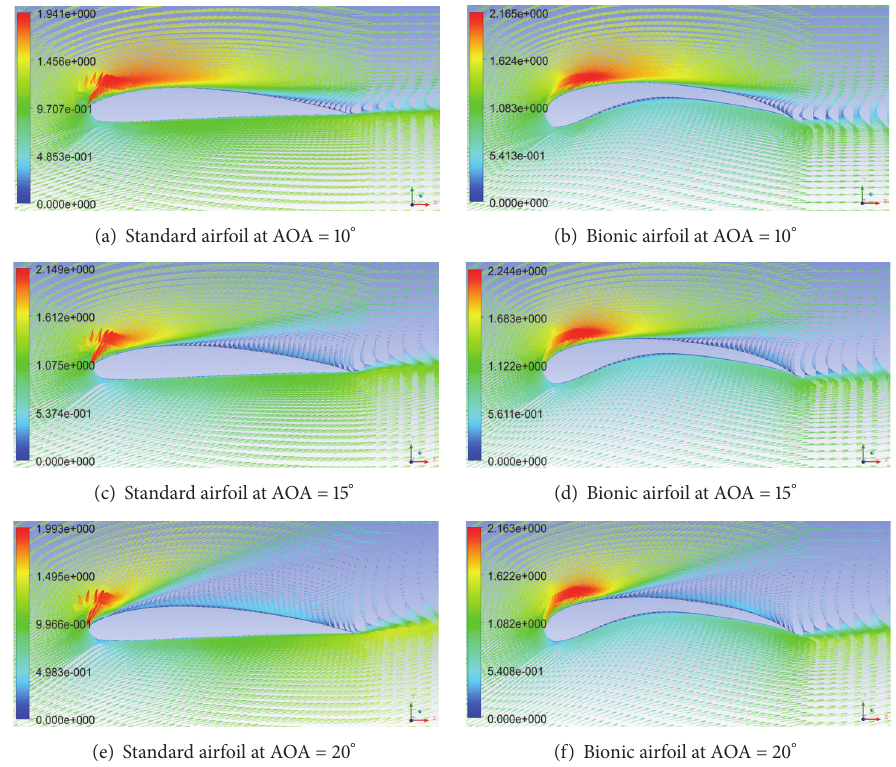
Figure 18: The velocity vectors colored by velocity magnitudes at Re = 8 × 10 4 at different angles of attack.